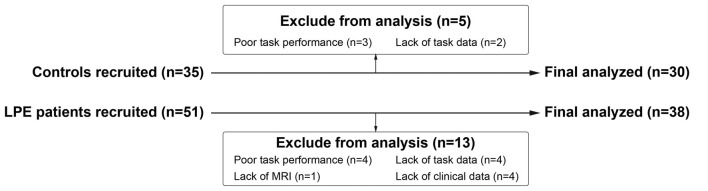
Diagram of participants recruited and excluded. MRI, Magnetic Resonance Imaging.